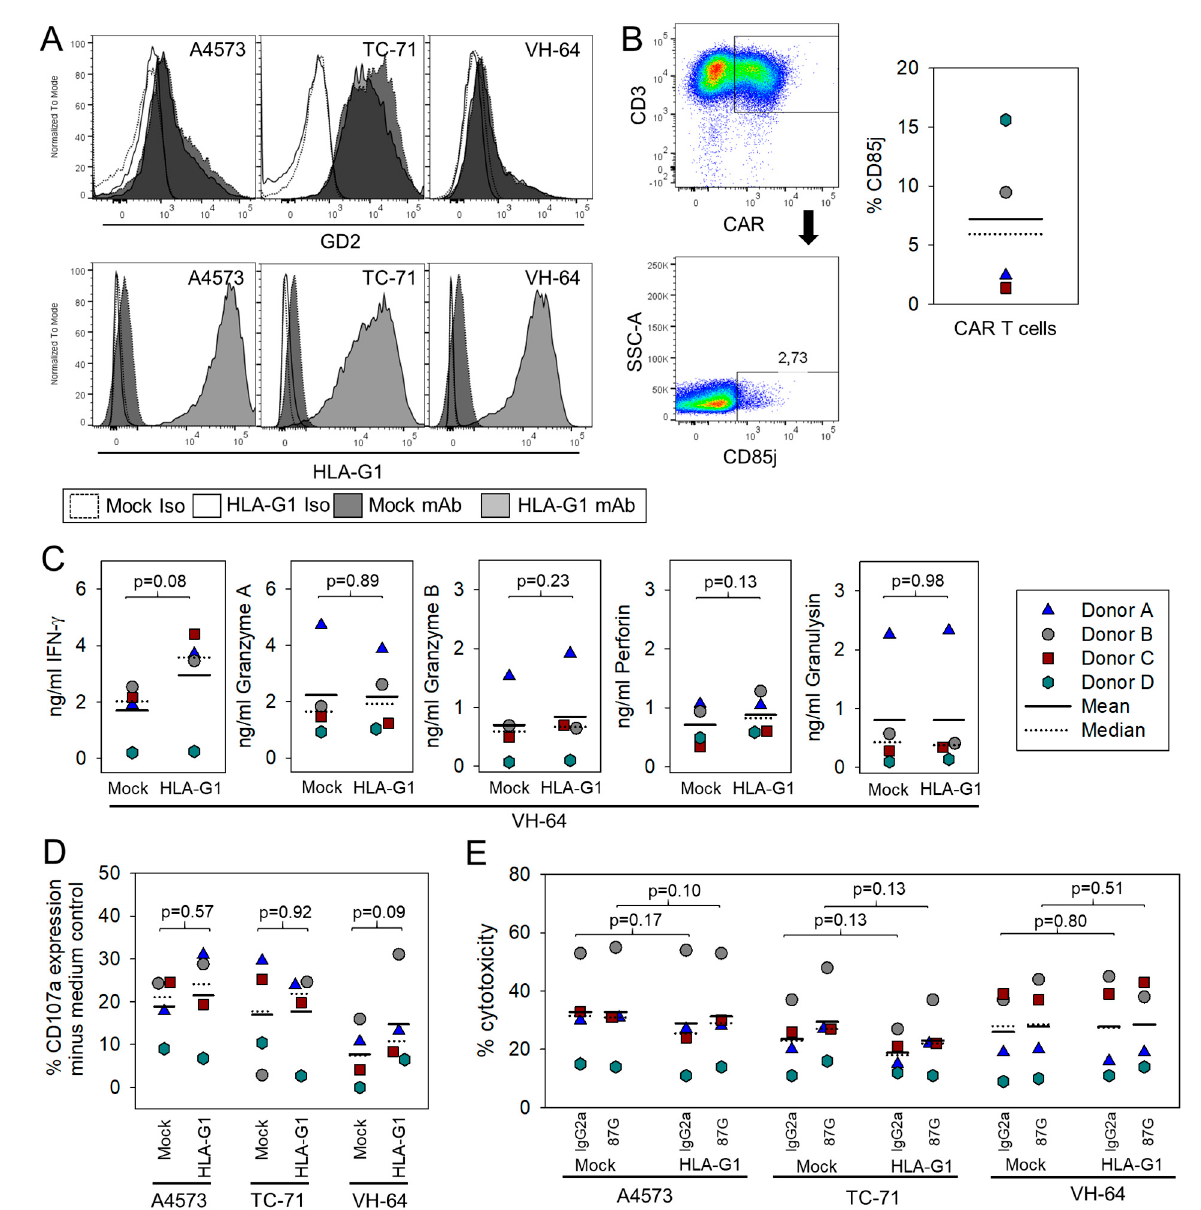
Figure 2. HLA-G1 expressed by EwS cells does not impair antigen-induced cytokine release or cytolysis by CAR gene- modified effector T cells. ( A ) HLA-G1 and G D2 expression on the cell surface of the G D2 -positive EwS cell lines A4573, TC-71 and VH-64. ( B ) CD85j (ILT-2) surface expression in GD2-BB ζ CART. ( C ) Secretion of IFN- γ and of perforin, granzymes A and B and granulysin by GD2-BB ζ CART, upon antigen-specific activation with HLA-G1- transduced and mock-transduced G D2 -positive EwS cells (VH-64). ( D ) CD107a upregulation by CD85j-expressing GD2.BB ζ CAR-transduced T cells from 4 individual healthy donors, in response to coincubation with HLA-G1 transduced G D2 -positive EwS cell lines. Mock-transduced EwS cells from the same cell lines (HLA-G1 neg) were used as controls. ( E ) Cytolysis of HLA-G1-transduced EwS cells from 3 G D2 -positive cell lines by GD2.BB ζ CAR-transduced T cells from 4 healthy donors, with and without preincubation (30 min) with HLA-G1-specific blocking antibody clone 87G (20 μ g/mL) or IgG2a control (E:T Ratio 40:1). Mock-transduced EwS cell lines (HLA-G1-neg) were used as controls. 3.3. HLA-G Expression on Myeloid Bystander Cells Reduces the Degranulation Response of G D2 -Specific CART After disproving a direct inhibitory interaction between the HLA-G-positive EwS cells and tumor-antigen specific CART, we addressed the hypothesis that myeloid bystander cells in the TME can mediate the T-cell inhibitory effects of HLA-G in this